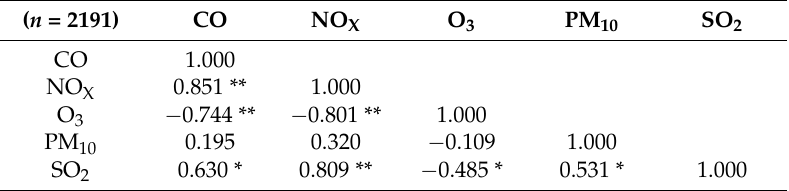
Table 3. Correlation between daily concentrations of the monitored air pollutants for 2016–2011 in Taiwan. ( n = 2191) CO NO X O 3 PM 10 SO 2 CO 1.000 NO X 0.851 ** 1.000 O 3 ´ 0.744 ** ´ 0.801 ** 1.000 PM 10 0.195 0.320 ´ 0.109 1.000 SO 2 0.630 * 0.809 ** 0.531